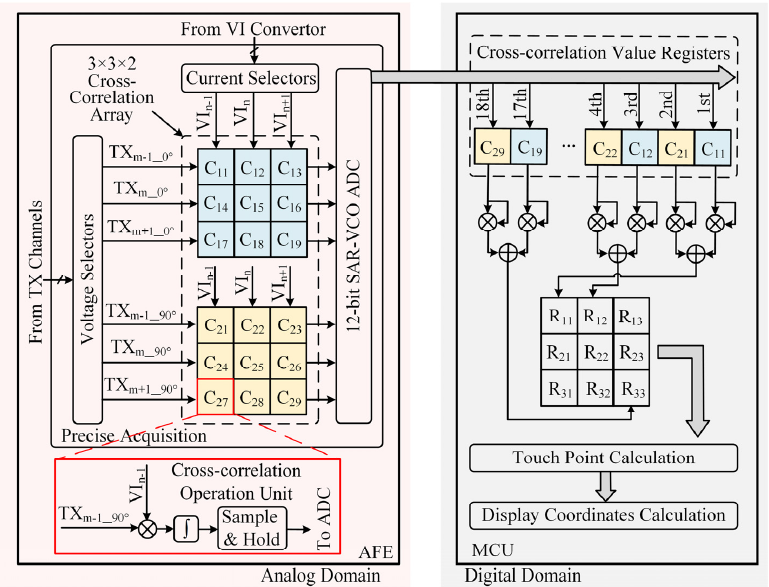
Figure 4. The data flow diagram of the proposed cross-correlation precise acquisition and calculation in the touch system.